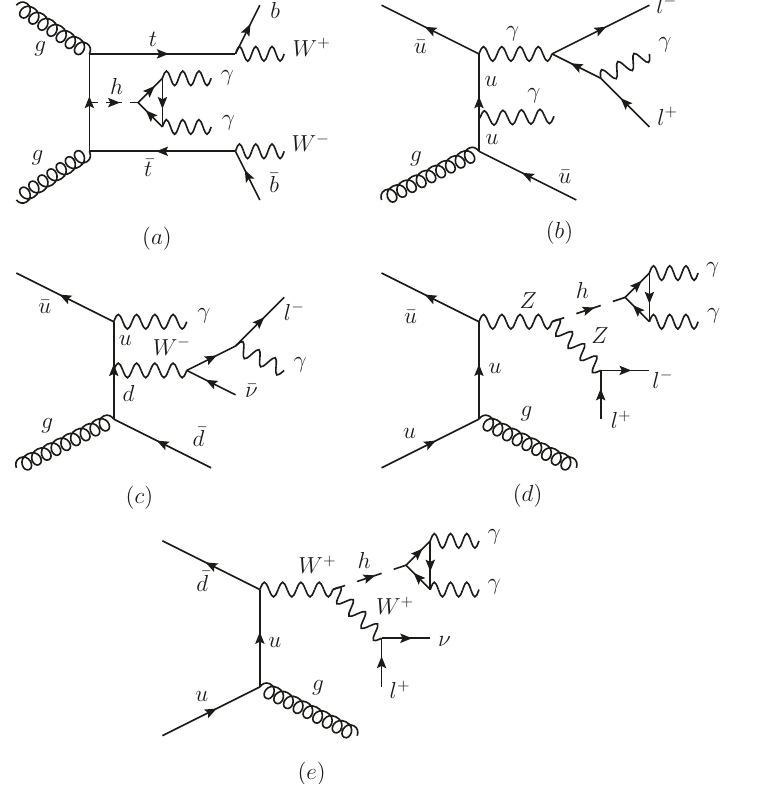
Figure 23 . Feynman diagrams for (a) t (cid:22) th , (b) ‘‘(cid:13)(cid:13) + jets, (c) ‘(cid:23)(cid:13)(cid:13) + jets, (d) Zh + jets and (e) Wh + jets background for the (cid:13)(cid:13)WW (cid:3)